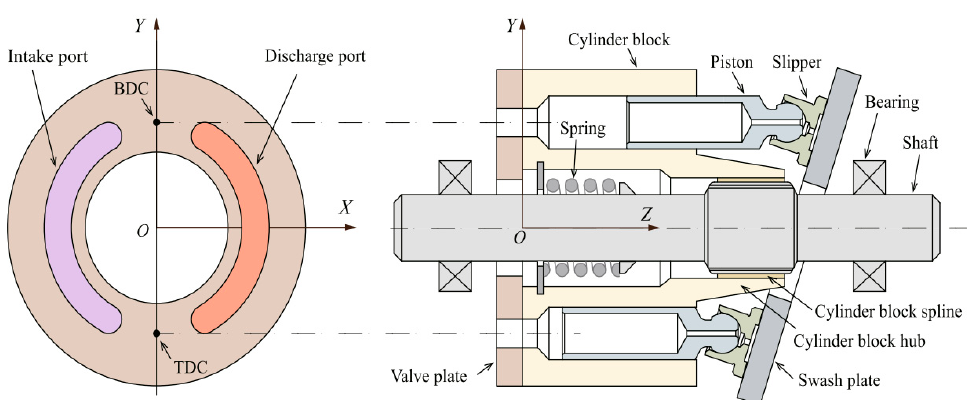
Figure 3. The general configuration of the swash-plate type axial piston pump. Reprinted with permission from Ref. [24]. 2017, Springer.